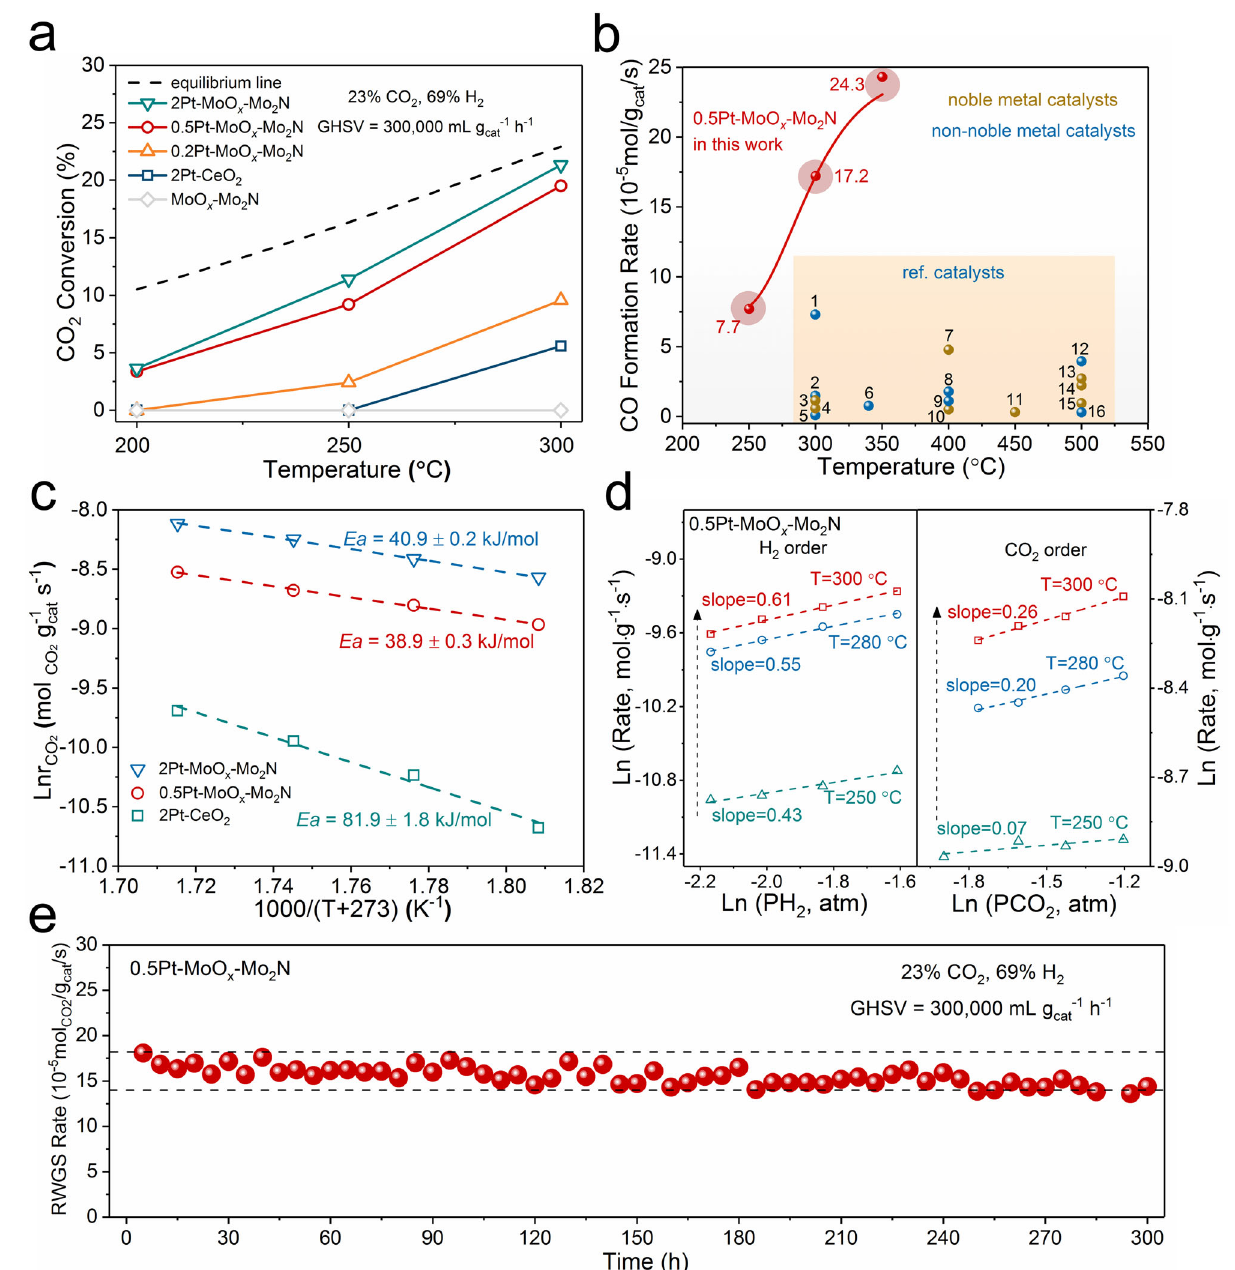
Fig. 2 | Catalytic performance of 0.5Pt – MoO x /Mo 2 N. a CO 2 conversion over dif- ferent catalysts at various temperatures. b The mass speci fi c activities of 0.5Pt – MoO x /Mo 2 N and other typicalcatalysts that wereused inRWGS reaction. (1) Cu/ β